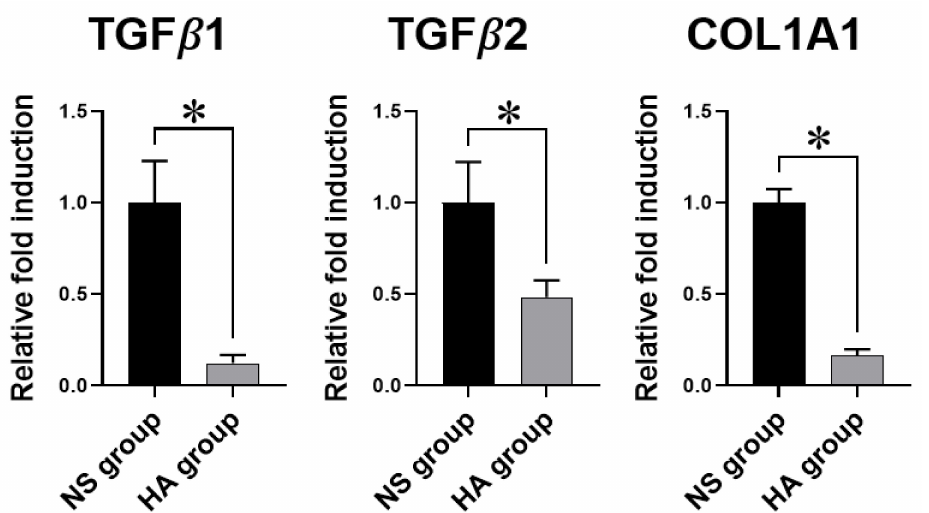
Figure 4. Quantitative polymerase chain reaction (PCR) analysis of fibrosis-associated genes TGF- β 1, TGF- β 2, and collagen type 1 α 1 chain (COL1A1). All gene expression levels are normalized to the levels of the NS group. Glyceraldehyde-3- phosphate dehydrogenase (GAPDH) is used as the reference gene. TGF- β 1, TGF- β 2, and COL1A1 expression is significantly lower in the HA group than in the NS group (all, * p < 0.05). Values represent the means ± standard error of the mean (SEM). ( n = 12 for each